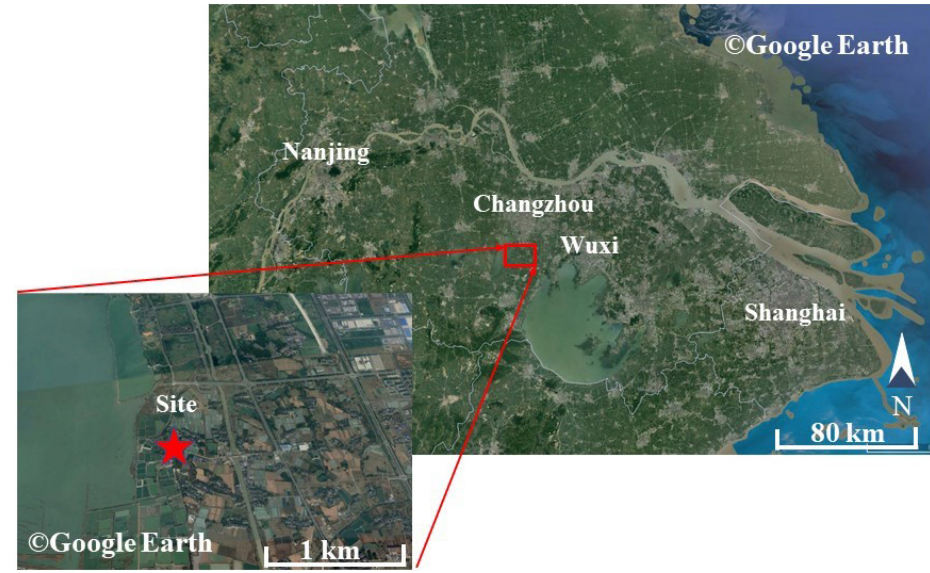
Figure 1. The location of the campaign site (red star), Changzhou, is 150km on the northwestern side of Shanghai.